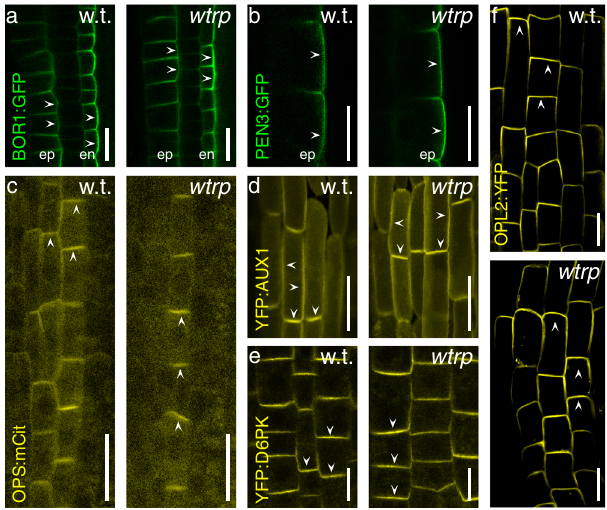
Fig. 3 | Subcellular localization of polarly localized PM-associated reporter proteinsin5DAGwildtype(w.t.)and wavtriple ( wtrp ).a BOR1::BOR1:GFP inroot meristem epidermis ( ‘ ep) and endodermis ( ‘ en ’ ) cells. b PEN3::PEN3:GFP in root meristem epidermis cells. c OPS::OPS:mCitrine in root meristem stele cells. d AUX1::YFP:AUX1 in root meristem LRC cells. e D6PK::YFP:D6PK in root meristem epidermis cells. f PIN2::XVE»OPL2:YFP in root meristem epidermis cells. Three independent experiments were performed for ( a – f ) with similar results. Arrow- heads indicate membrane localization of reporter protein signals. Size bars: a – f =10 μ m.